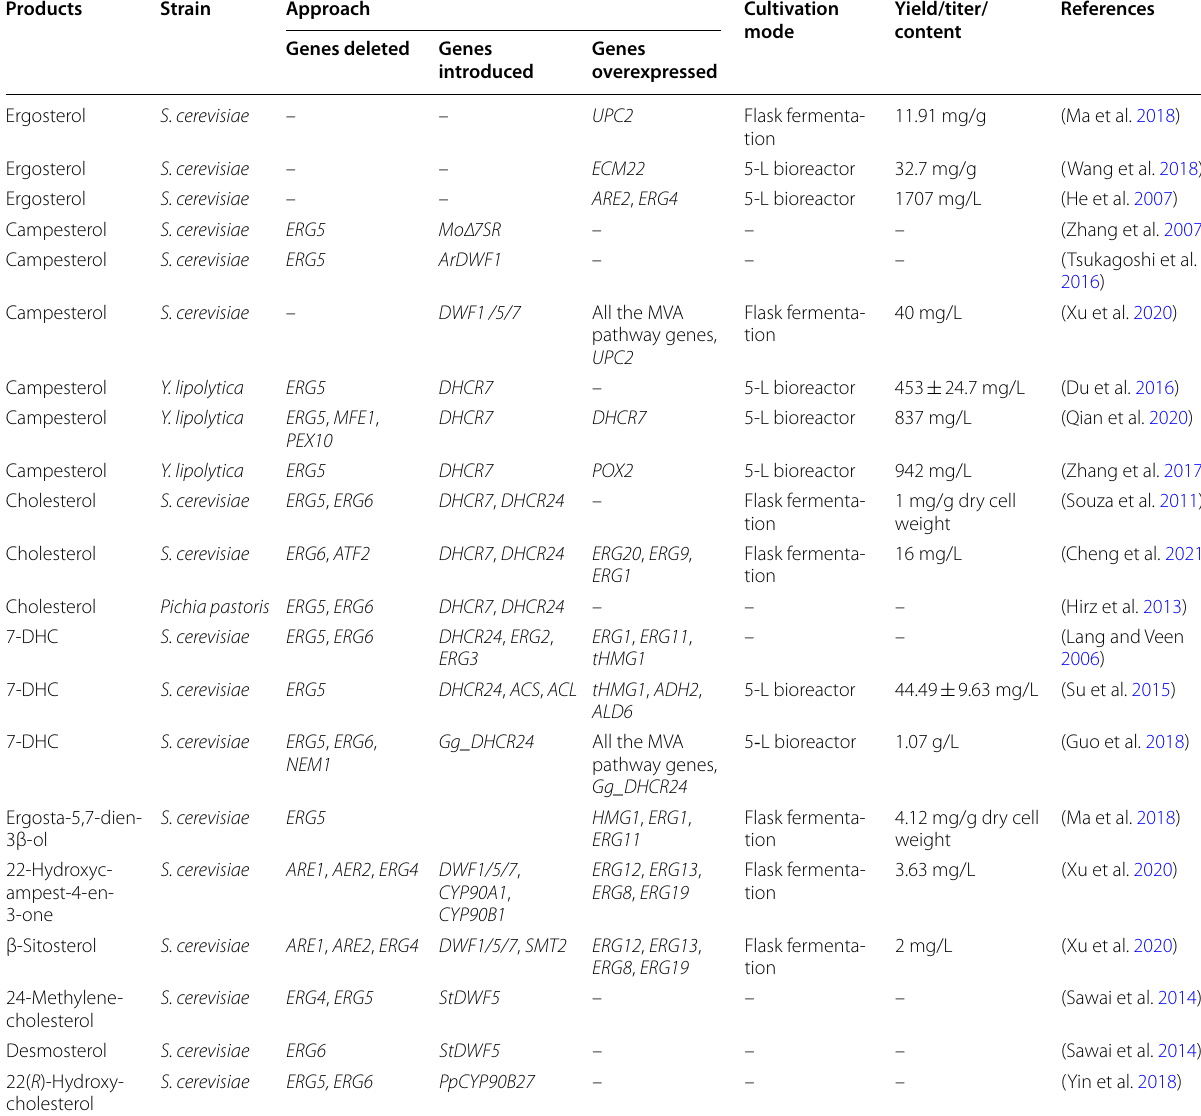
CYP90A1 encoding C3-oxidase; CYP90B1 encoding C22-hydroxylase; StDWF5 encoding sterol Δ 7 reductase; PpCYP90B27 encoding steroid C22 hydroxylase